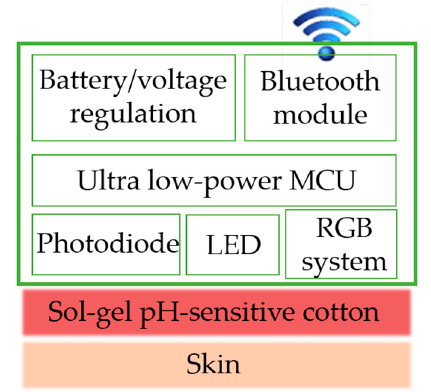
Figure 2. Block diagram of smart halochromic sensor.